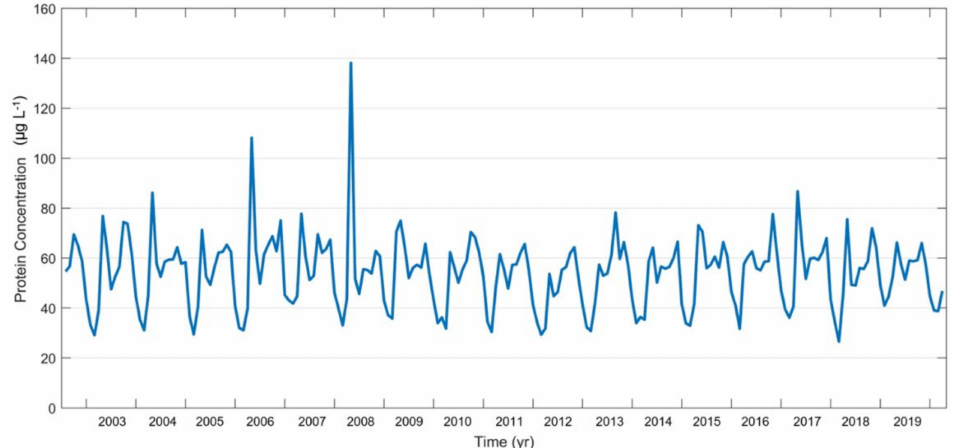
Figure 7. Time-series of monthly mean protein concentration of phytoplankton in East/Japan Sea (EJS) from January 2003 to December 2019.